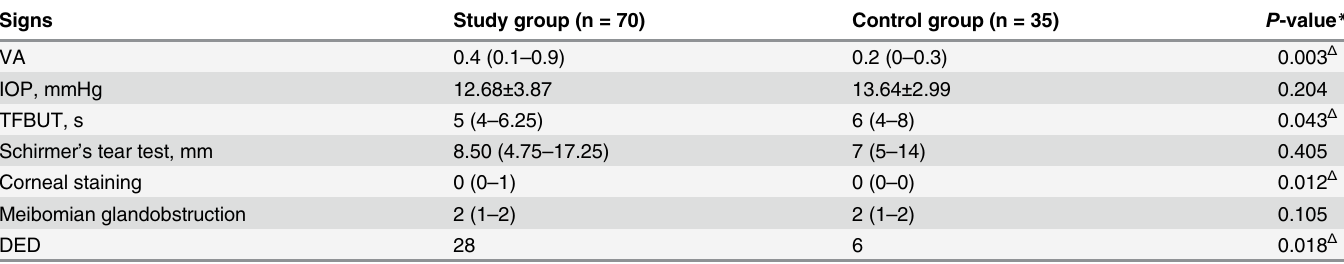
Table 3. Ocular surface signs in the study and control groups.